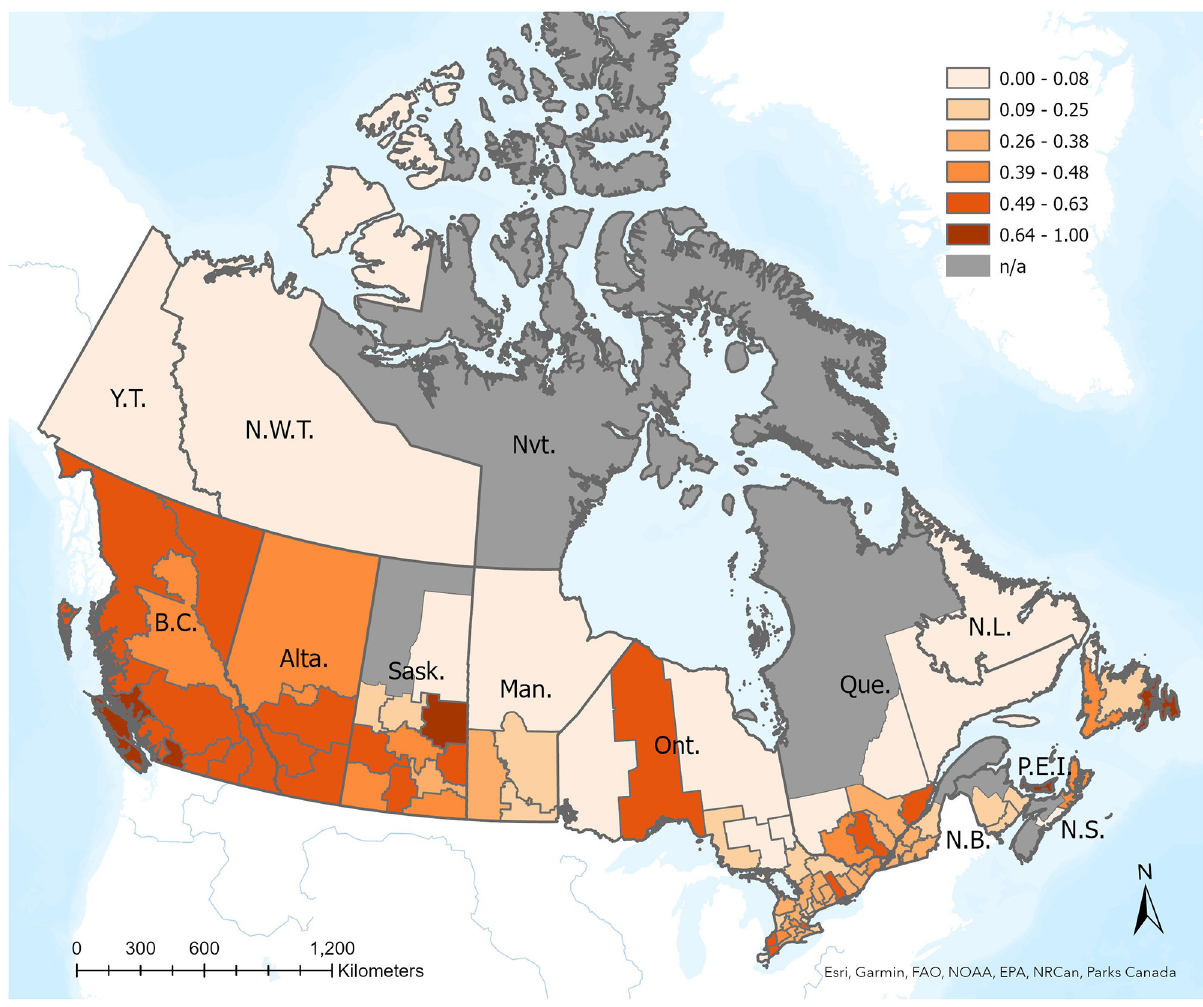
Fig 1. Distribution of bat submission for rabies testing to CFIA during 2014–2020. Samples are pooled across public health authorities and the percent of submission of bats that were associated with cats is shown in a gradation of orange with darker red indicating a higher percentage. Public heatlh authorities with no submissions are depicted in grey with a n/a designation. Maps were created using ArcGIS by ESRI version 10.5 using basemaps from www.arcgis.com and